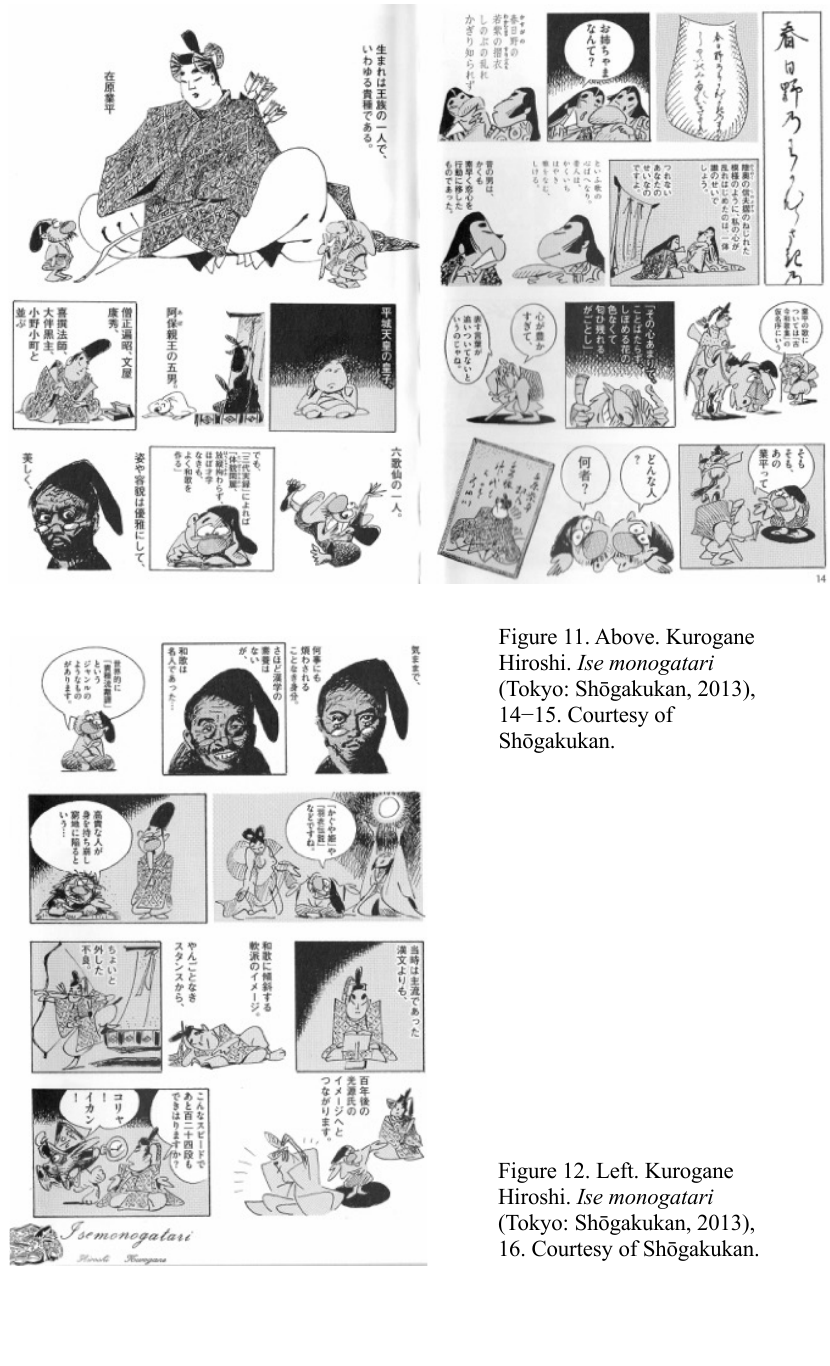
Figure 11. Above. Kurogane